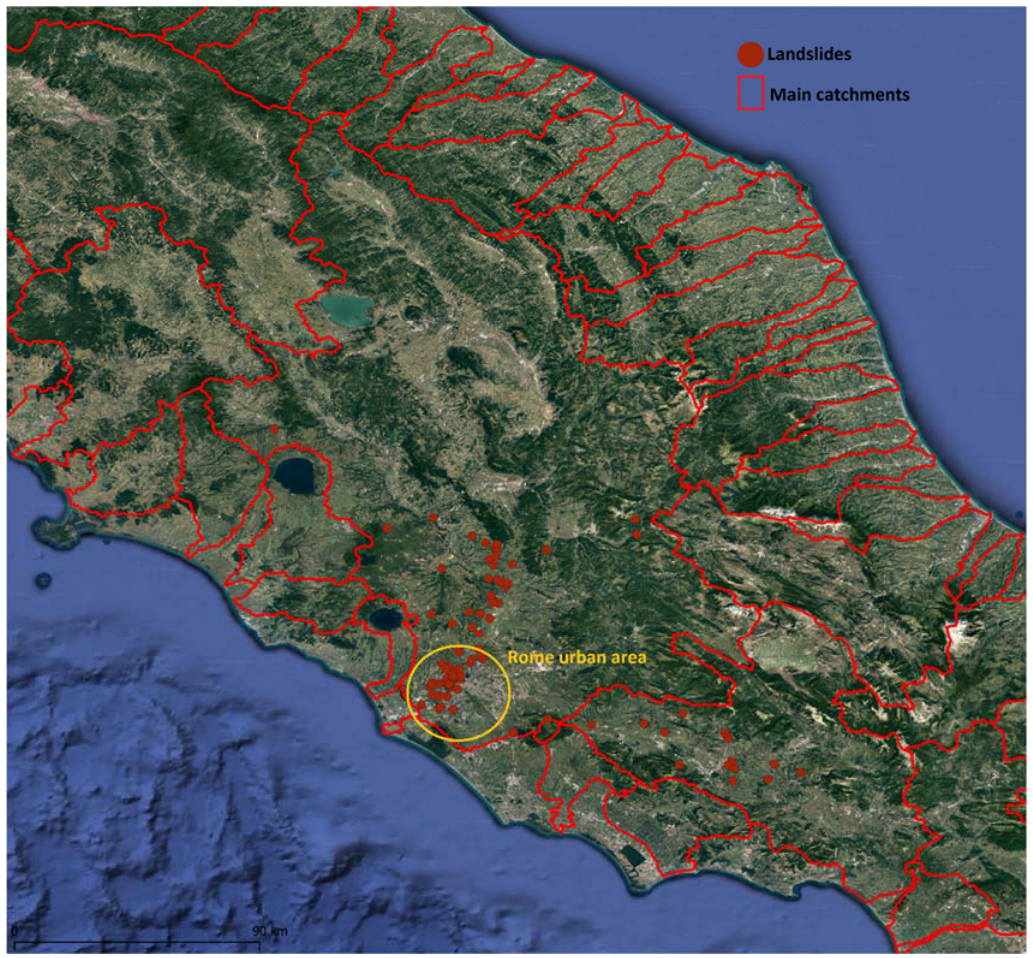
Figure 1. Location of landslide events (brown circles) reported during the event in the Lazio Region Civil Protection Report and press releases. The yellow circle indicates the urban area of Rome. For a better localization of each phenomenon, the file named “Domain.kmz” for the visualization on GoogleEarth© is provided in the Supplementary Material.